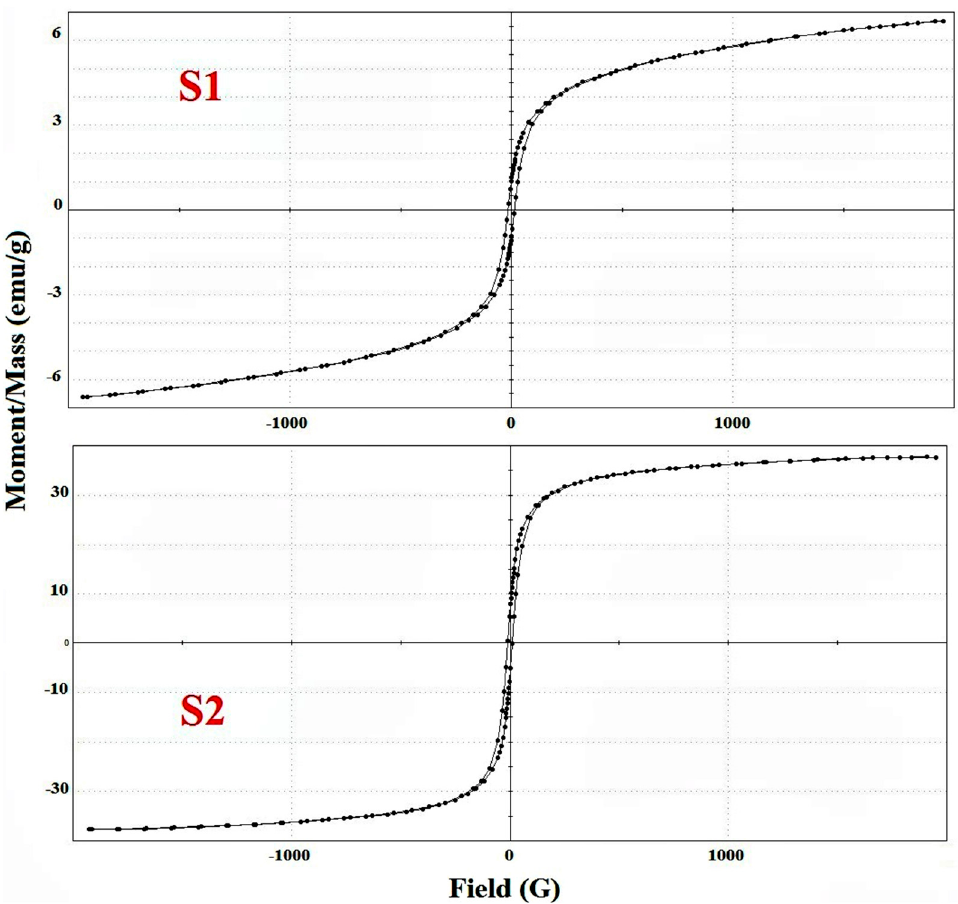
Table 3 . The magnetic properties of the S1 and S2 samples.